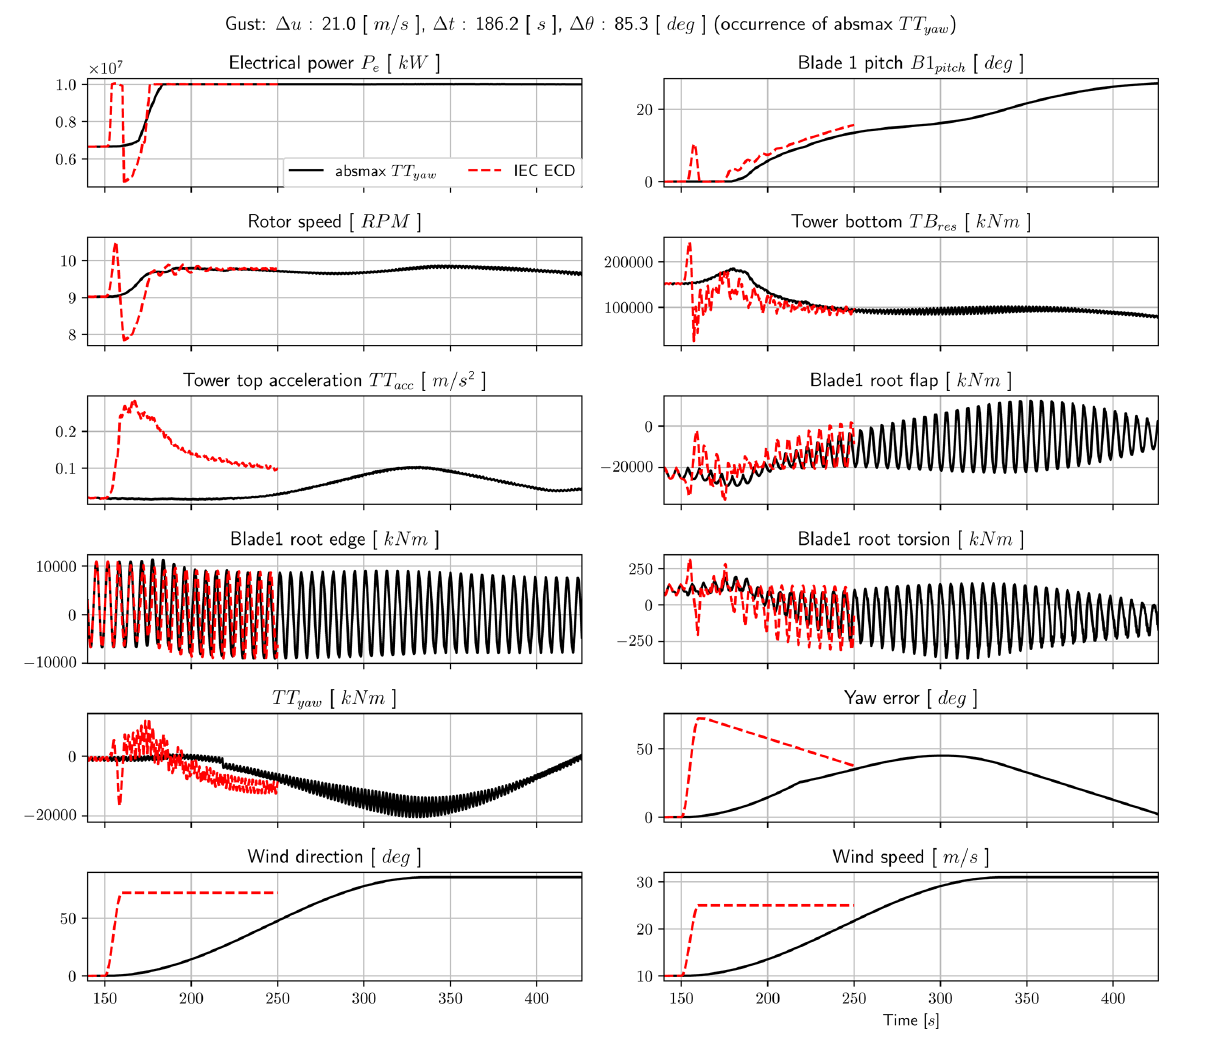
Figure A2. Gust for which the tower-top yawing moment TT yaw has the absolute maximum (see also Table 2). Note that the label is only shown in the upper-left figure (solid line for the gust case as indicated in the panel title and dotted line for the IEC ECD